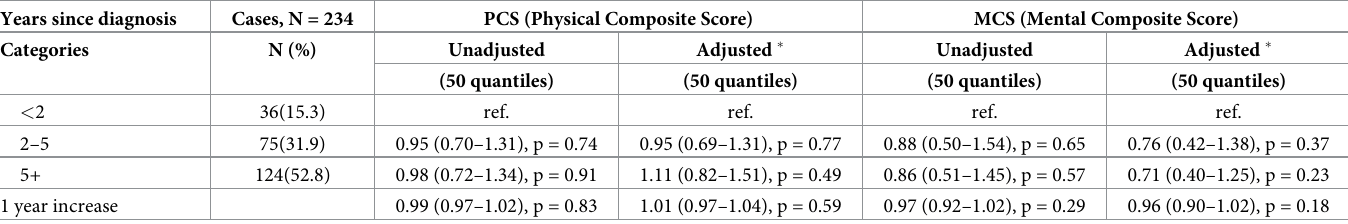
Table 3. ORs (odds ratios) and 95% confidence intervals (95% CI), estimated using logistic quantile regression, of median of PCS and MCS for time since cancer diagnosis.